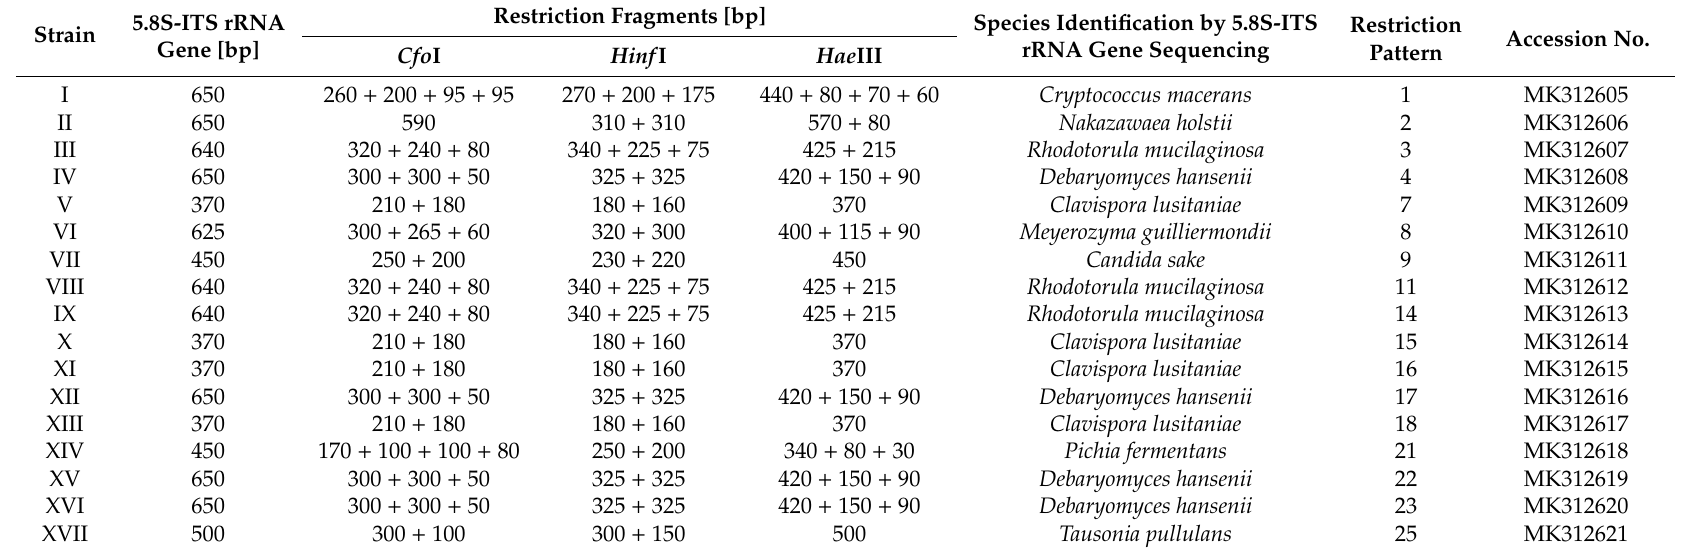
Table 1. Identified species of yeast based on the results of the RFLP analysis and 5.8S ITS rRNA gene